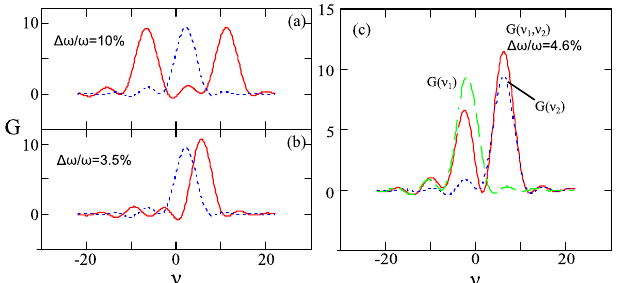
FIG. 3. Gain function G ð ν 1 ; ν 2 Þ , derived from Eq. (1), versus the detuning parameter for ρ ≅ 1 . 67 × 10 − 3 , N ¼ 150 , g 0 ≅ 10 with (a) Δ ω = ω ≅ 10% (continuous line) and (b) Δ ω = ω ≅ 3 . 5% . In both graphs the dotted line refers to the case with Δ ω = ω ≅ 0 and g 0 ≅ 5 . In (c) a comparison with the disentangled gain curves centered around the respective peaks with ν ≅ (cid:4) 4 is reported (blue dotted and green dashed